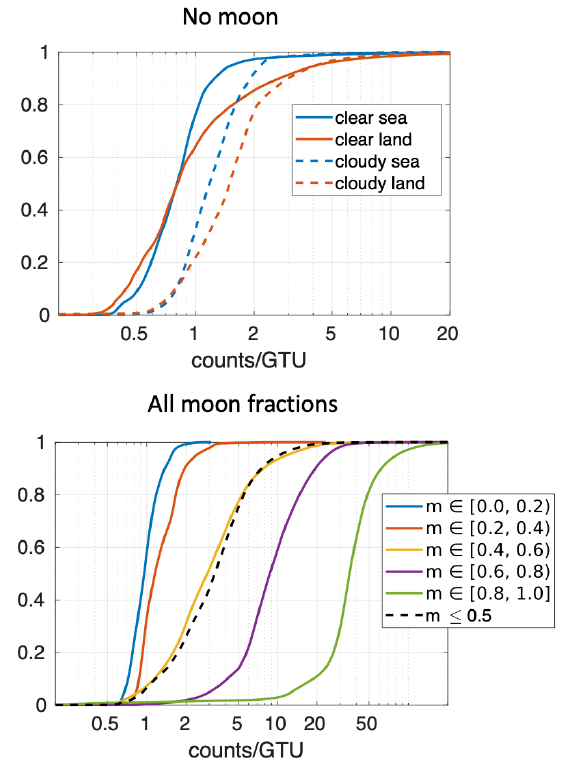
Figure 4. Top: cumulative distributions of Mini-EUSO obser- vations over land and sea regions. Solid lines indicate moonless and cloudless conditions. Dashed lines represent moonless and cloudy conditions, i.e. GFS cloud fraction above 1%. Bottom: cumulative distributions of observations with the Moon visible above the horizon, each curve representing a di ff erent moon- phase interval. Figure adapted from [24].